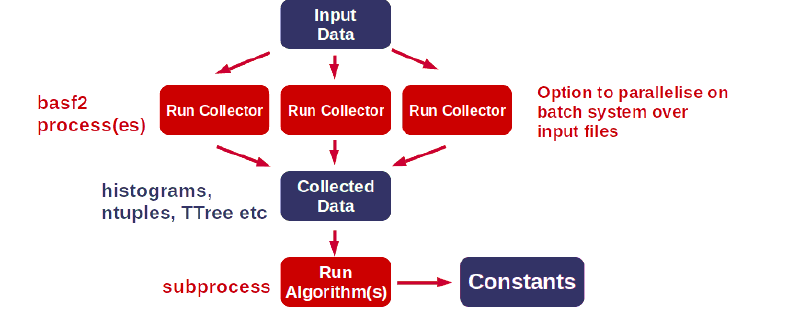
Figure 2. Data processing flow for a single iteration of a single calibration in the CAF. The outputs of the workflow are calibration constants saved to files. Most calibrations will iterate this process, using the previous constants as input, and may chain dependent calibrations together.